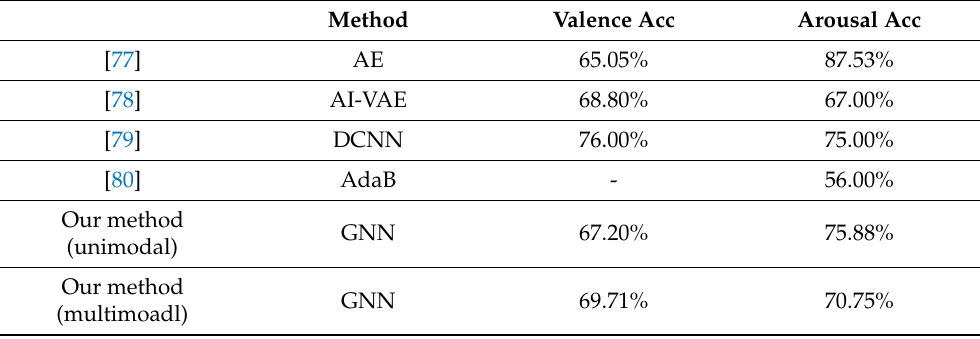
Table 10. Comparison of accuracy found in the